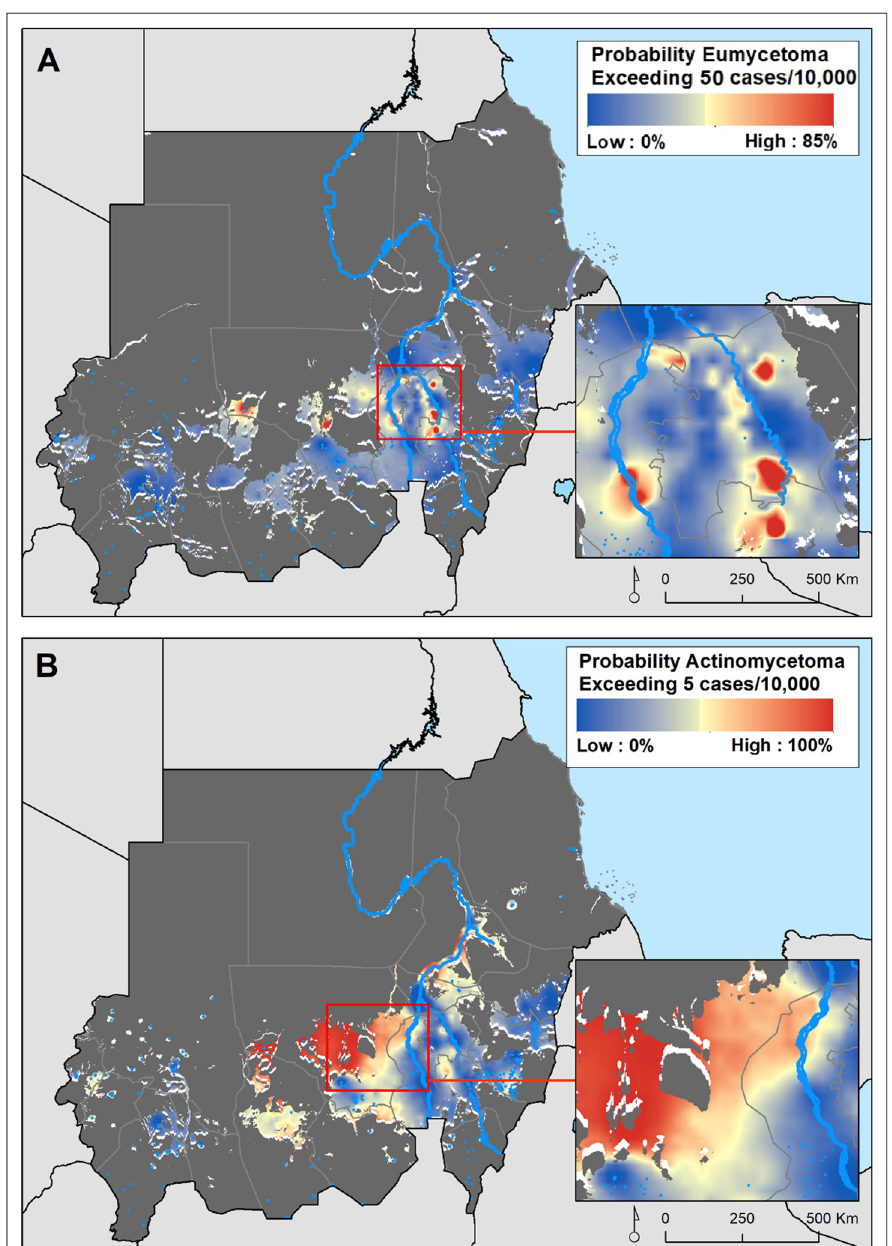
Fig 4. Maps displaying the probability of exceeding 50 cases and 5 cases per 1,000 inhabitants, for eumycetoma and actinomycetoma respectively, since 1991 in Sudan.